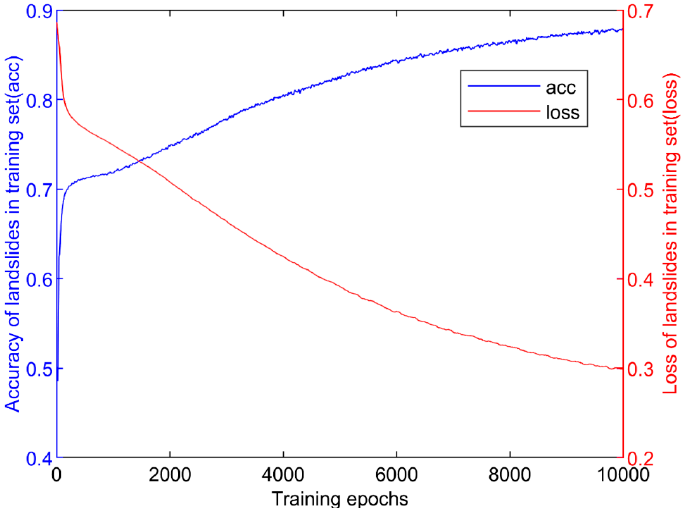
Figure 9. Loss and accuracy curves throughout the training of the models.